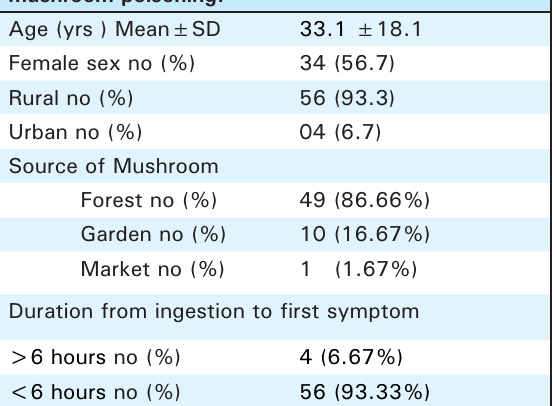
Table 1. Baseline characteristics of patients with mushroom